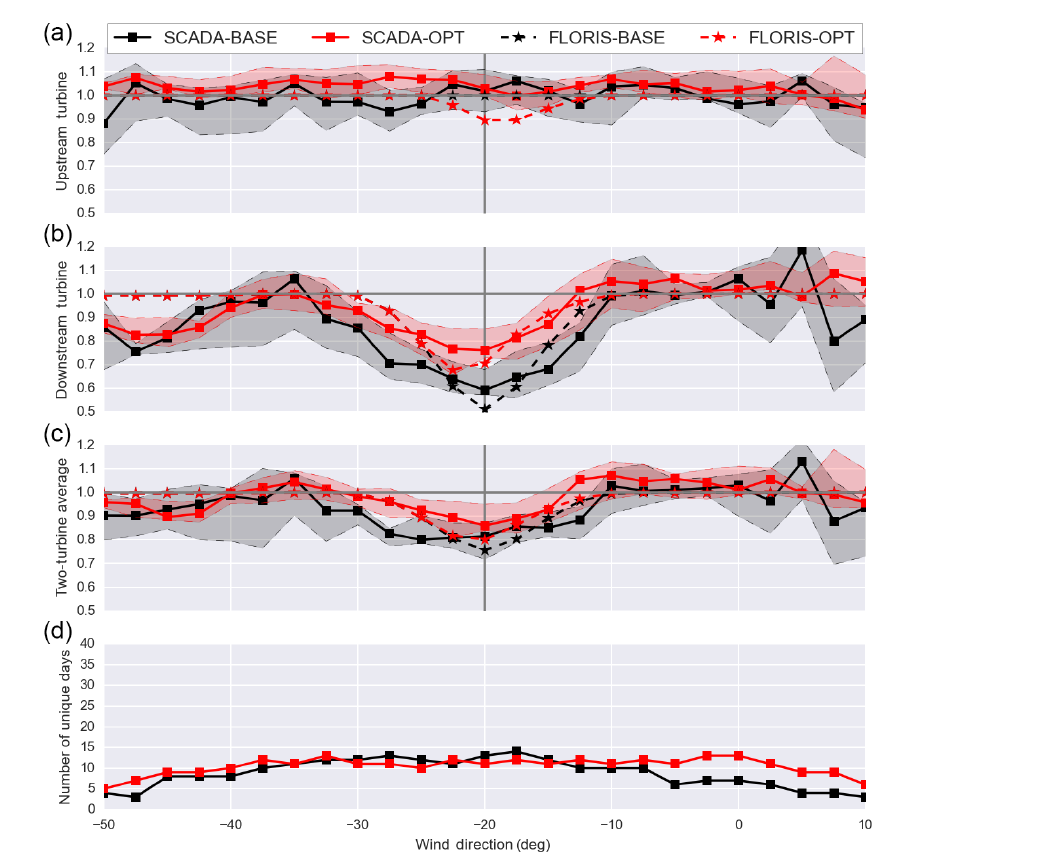
Figure 6. This figure shows the results fitting power curves for the turbine C1 to turbine D1 pair. FLORIS-BASE refers to the results from the FLORIS model with no wake steering, and FLORIS-OPT refers to the results from the FLORIS model with the optimal yaw set points. SCADA-BASE refers to the field test where the controller was off, and SCADA-OPT refers to the field test where the controller was on. The banded region shows the range of fit values from the 25th to 75th percentile of fitted power curves. In particular, (a) shows turbine C1 and the resulting power with the controller on (red) and off (black). Panel (b) shows the downstream turbine, i.e., turbine D1, with the offset controller of C1 on (red) and off (black). Panel (c) shows the overall power between the pair of turbines. There is a significant power gain when the controller is on versus when it is off. Finally, (d) indicates the number of days used to compute the statistics provided in the top three